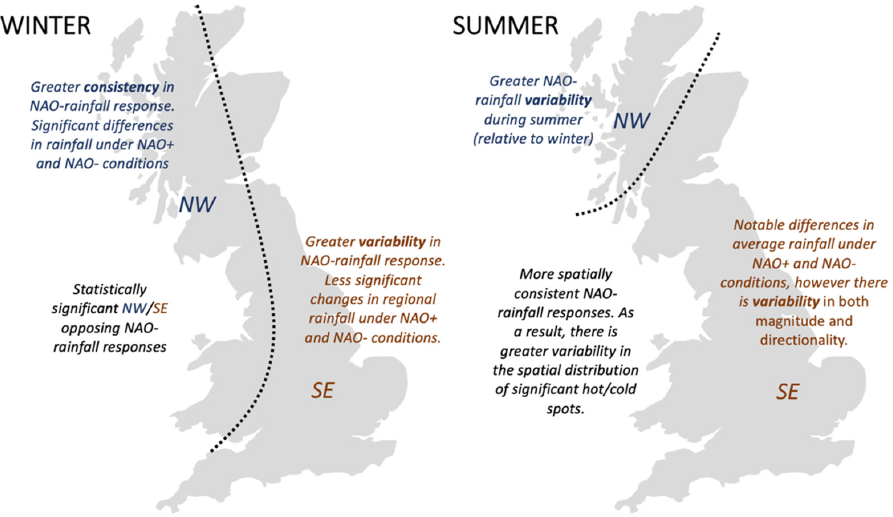
Figure 13. Schematic representation of the key spatio-temporal differences observed in NAO-rainfall response during the winter and summer months.